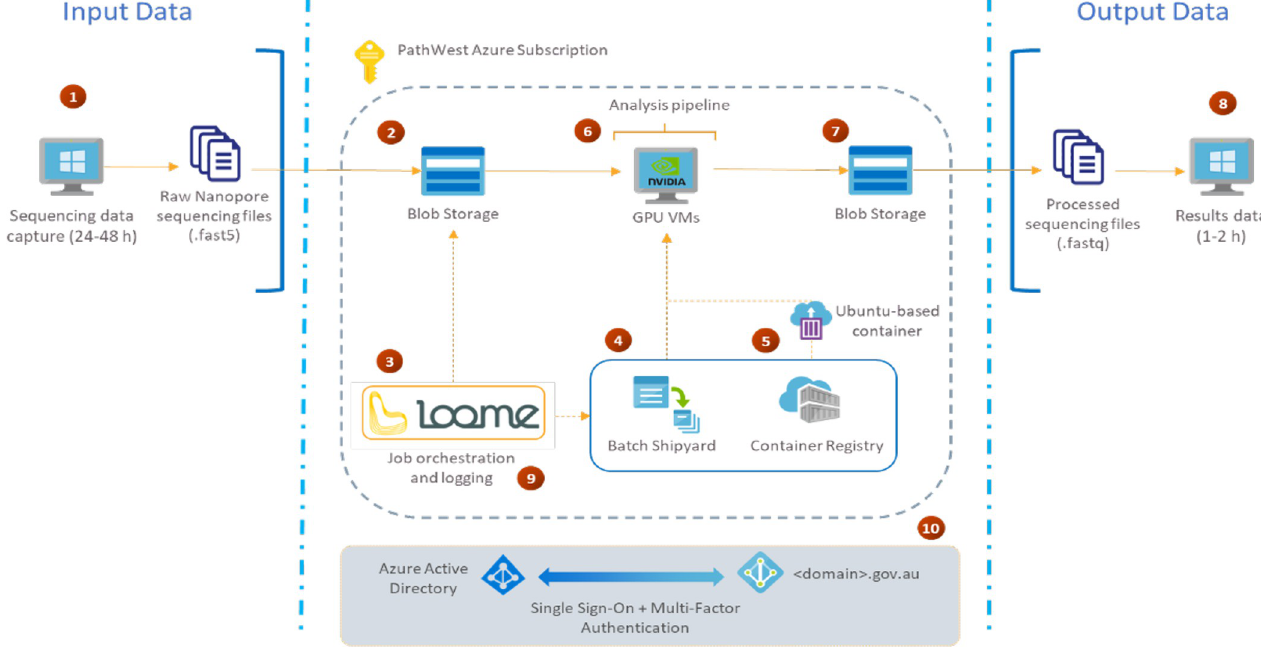
Fig 2. The architecture of analysis pipeline on the Microsoft